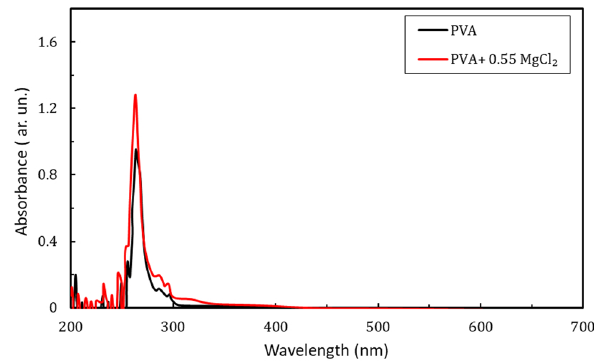
Figure 8: UV - Vis spectra of PVA and Mg - PVA ( 0.55 g MgCl 2 ) .